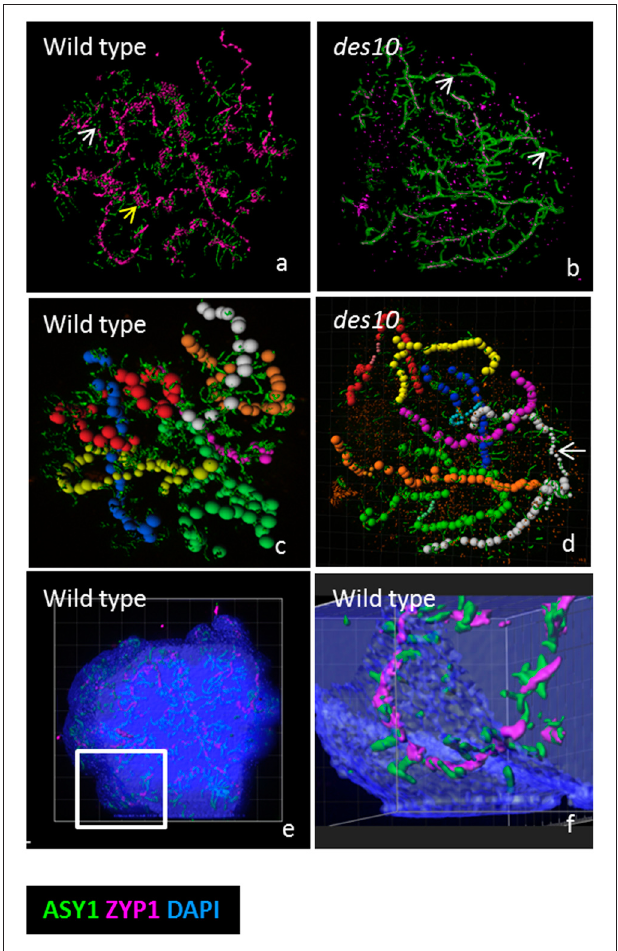
FIGURE 2 | Modeling of the tinsel structure in wt and des10. Modeling the tinsel structure in wt (a) and des10 (b) by creating “surfaces” for ASY1 and ZYP1 using Imaris surface tool (a,b) . This revealed areas of axes with no ZYP1 (white arrow) in both wild type (a) and des10 (b) , suggesting dissolution of the SC. ZYP1 aggregates were visible in wild type (a, yellow arrow), with abundant surrounding ASY1, that could suggest contraction of local chromatin. Individual bivalents are manually tracked using the Imaris measurement tool (c,d) revealing different thickness of bivalent areas in des10 (d, white arrow), that may suggest differences in the thickness of the remnant ASY1 axes. Using the tool surface on DAPI channel (with 50% transparent effect to view inside the DAPI signal) revealed that ASY1 remodeling remains within the chromatin (e,f)